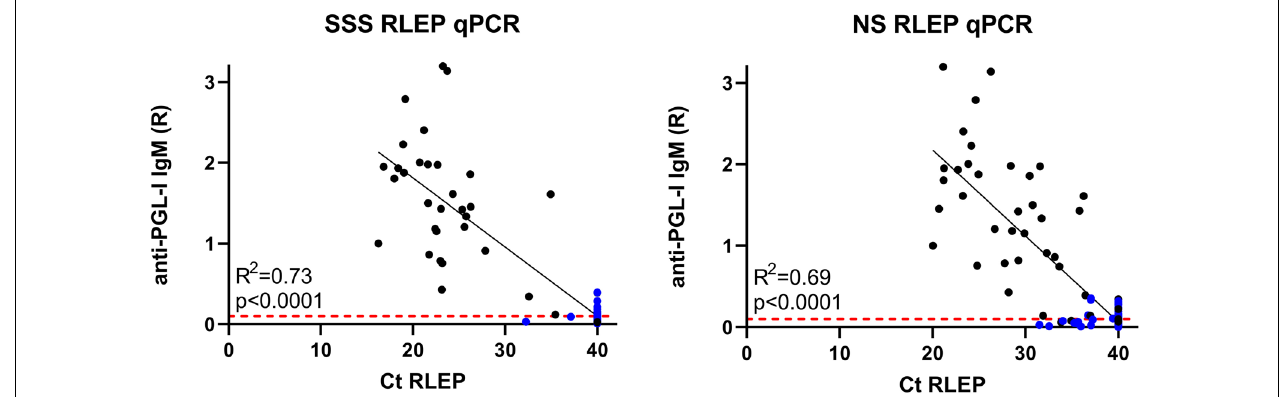
FIGURE 4 | Correlation of IgM antibodies against PGL-I to Ct of RLEP qPCR. Quantified levels of pathogen DNA (qPCR) and host immunity were correlated for samples selected for qPCR analysis based on RLEP positivity in multiple individuals in one household. Each dot represents a sample from one individual; leprosy patients are indicated in black, and healthy household contact in blue. Anti-PGL-I antibody levels were measured by up-converting reporter particles lateral flow assay specific for M. leprae PGL-I IgM antibodies ( α PGL-I UCP-LFA) using the Ratio (R) of the Test (T) and flow control (FC) lines as units. Ratios of ≥ 0.10 were considered positive as indicated by the red dashed line. RLEP cycle threshold (Ct) values are indicated on the x -axis and were measured by qPCR to detect M. leprae DNA in slit skin smears (SSS, left ) and nasal swabs (NS, right ). Undetermined Cts are depicted as Ct